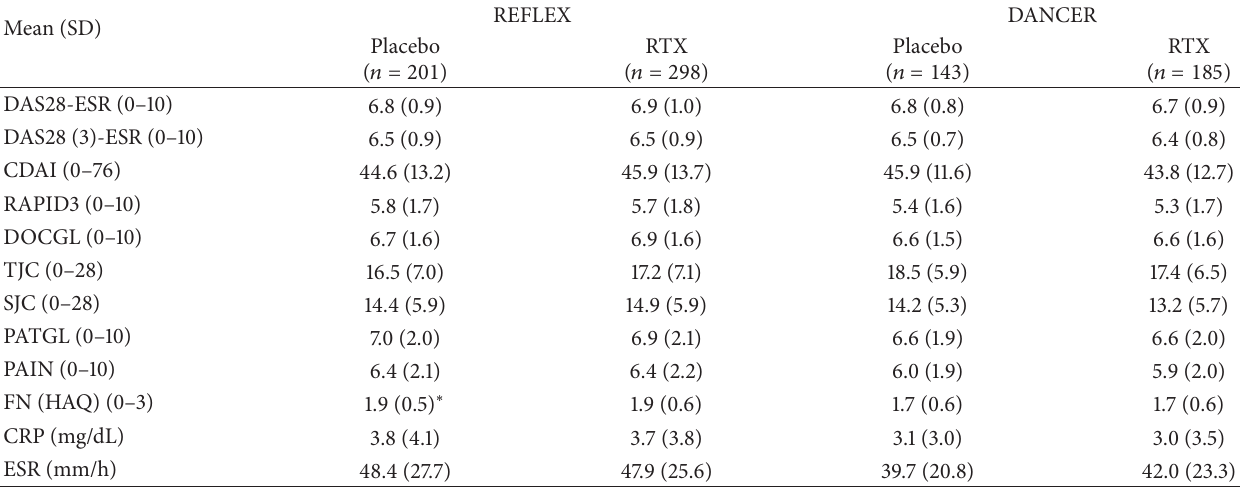
in 28 joints excluding patient global health component; DOCGL: assessor global; ESR: erythrocyte sedimentation rate; FN: physical function; HAQ: Health Assessment Questionnaire; PAIN: pain; PATGL: patient global estimate; RAPID3: Routine Assessment of Patient Index Data 3; RTX: rituximab; SD: standard deviation; SJC: swollen joint count; TJC: tender joint